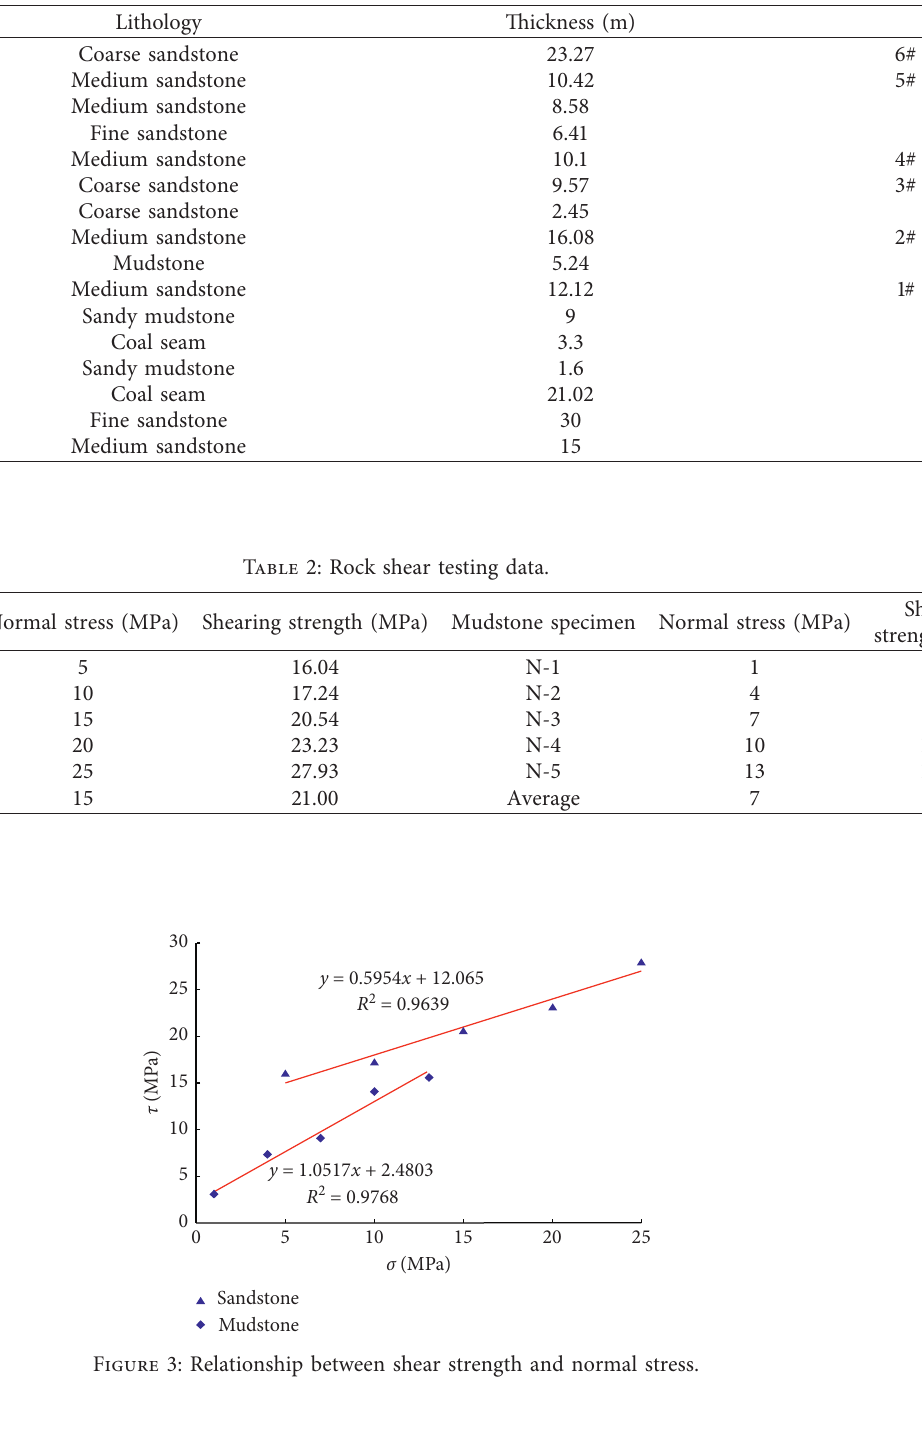
Table 1: Rock stratum occurrence of 8101 working face.